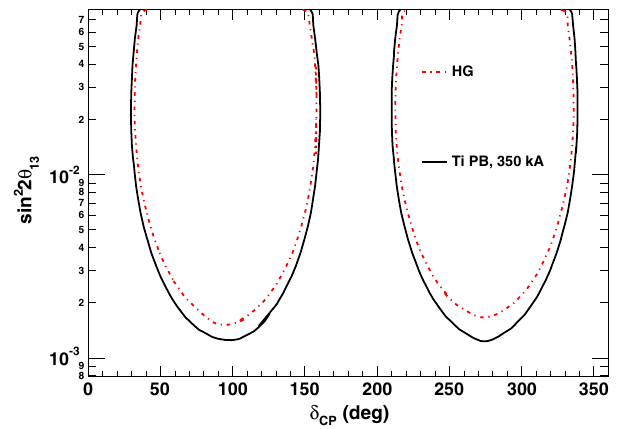
FIG. 31. CP violation discovery potential at 3 σ level in the (sin 2 2 θ 13 , δ ) plane. The continuous line corresponds to the CP reference configuration described in this article. The red dashed- dotted line corresponds to a notional mercury target considered in previous studies.